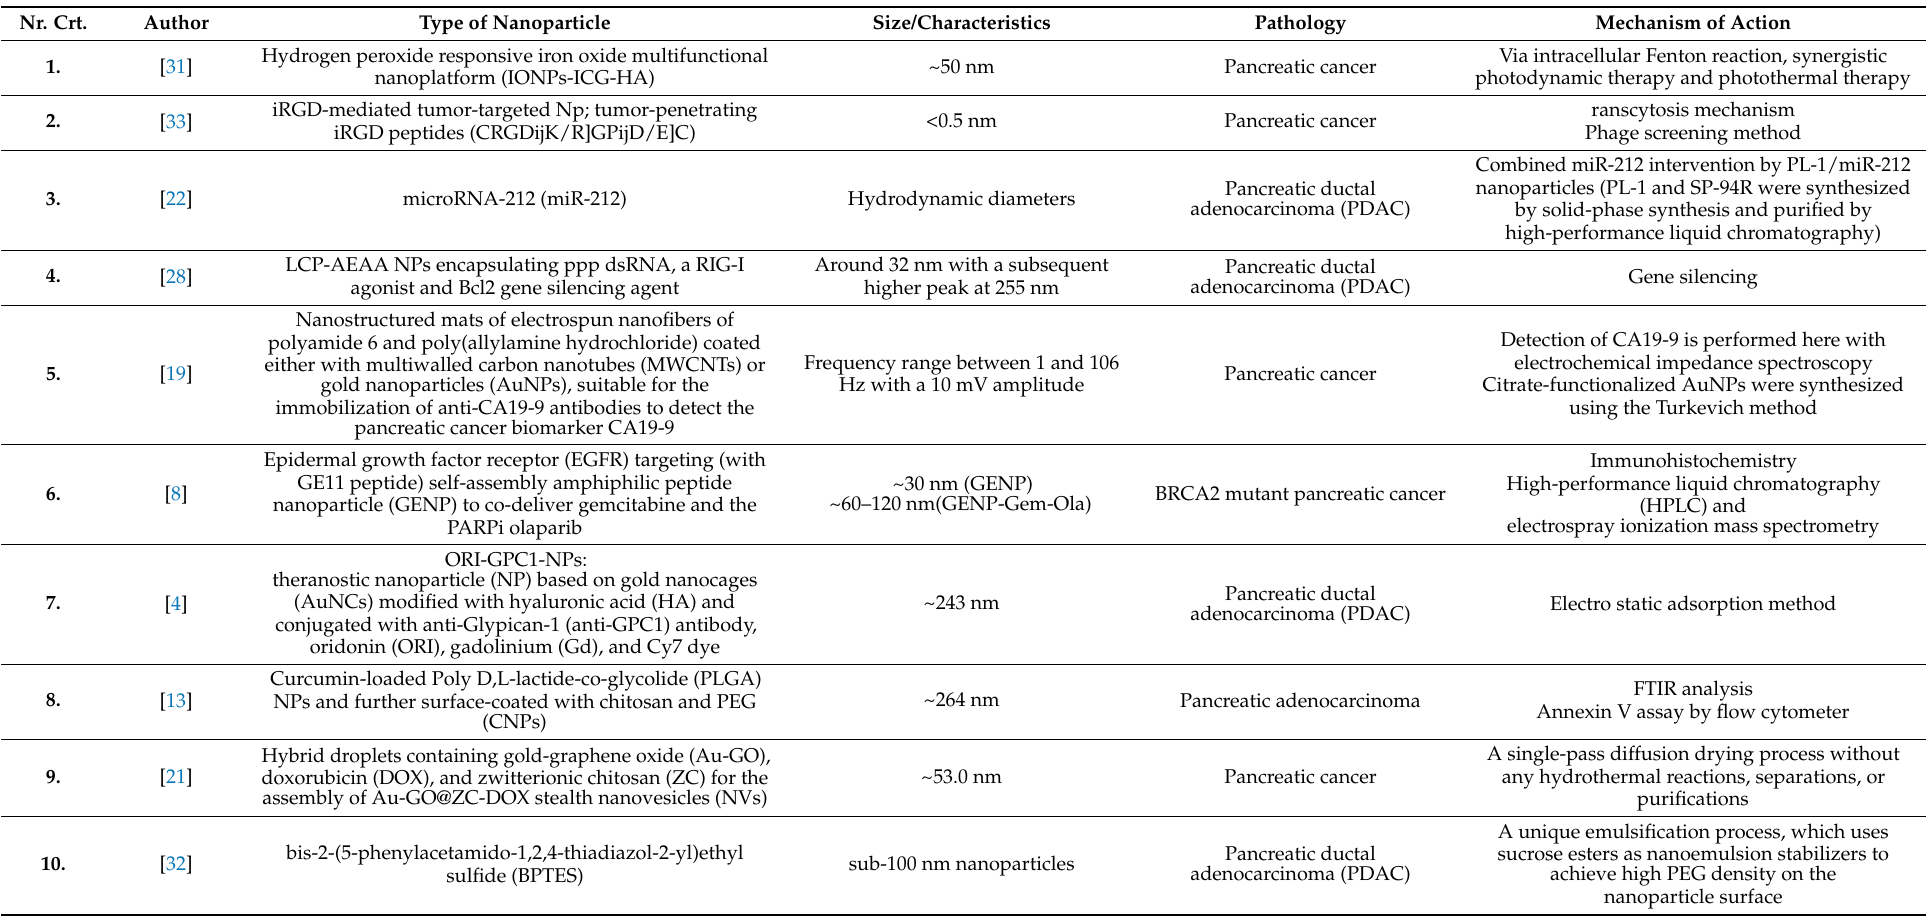
Table 1. Nanoparticles used for pancreatic cancer